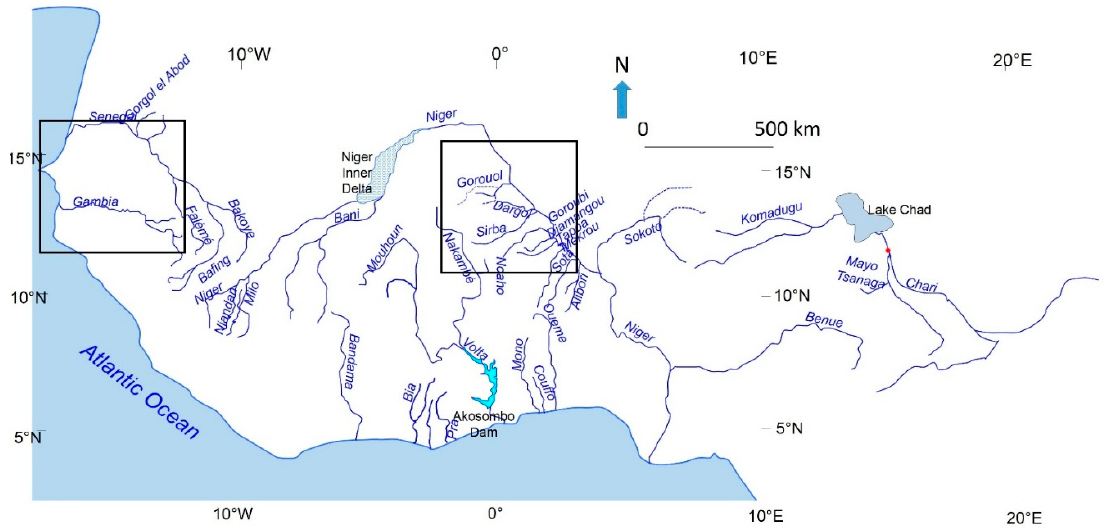
Figure 9. Location of the two areas cited in Figures 11–13: Senegambia (left square) and the Middle Niger River Basin (MNRB) (right square).